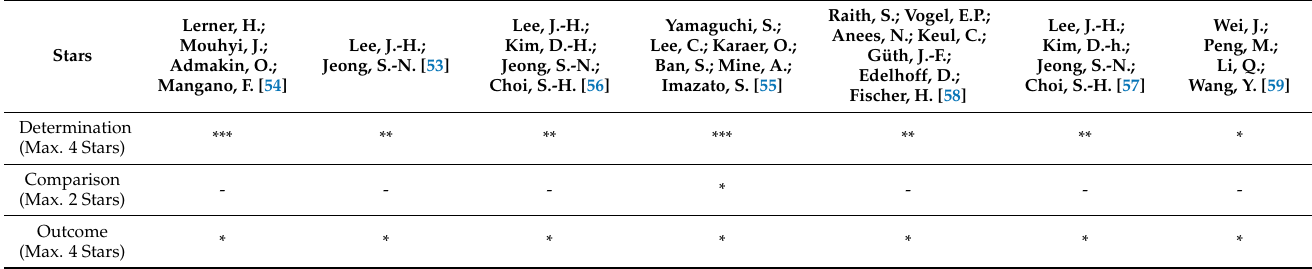
Table 3. Study bias assessment. (* shows the presence of the factor